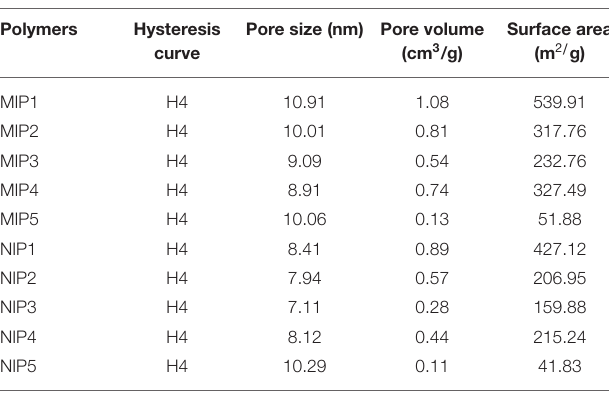
TABLE 4 | BET data for MIPs and NIPs.